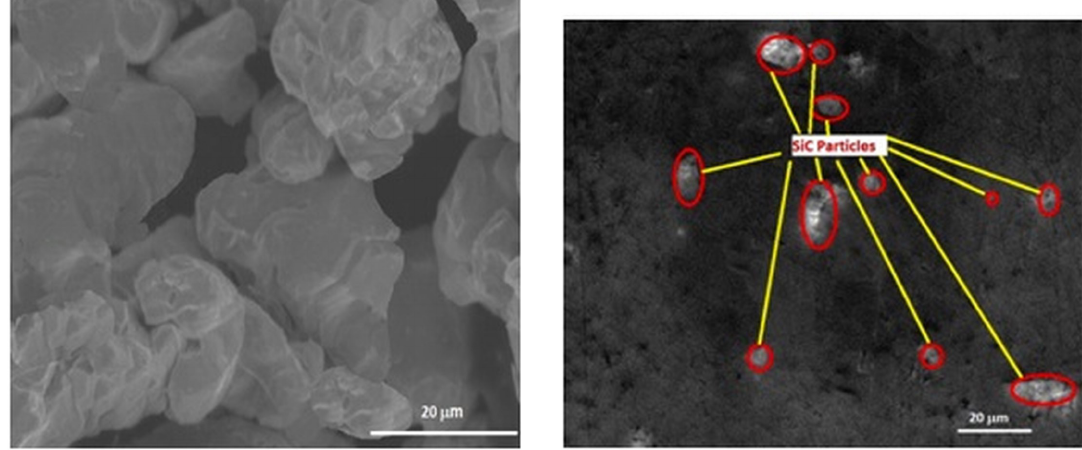
Figure 1. SEM image of SiC particles. Figure 2. SEM image of the brass